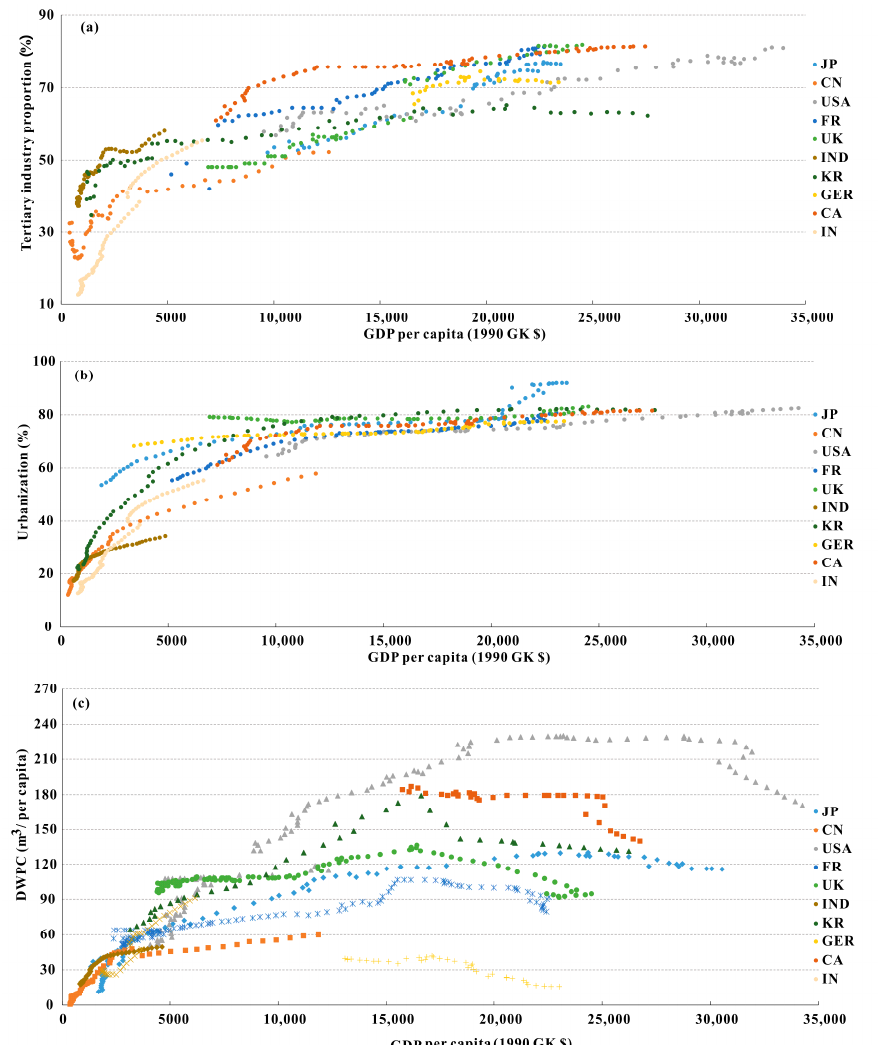
Figure 6. Relationships between GDP per capita and ( a ) tertiary proportion, ( b ) urbanization, and ( c ) tertiary proportion of GDP.